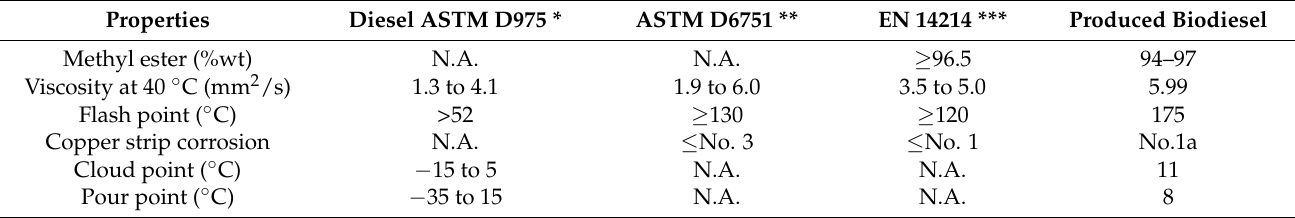
Table 3. Fuel properties of lipids from transesterification of palm